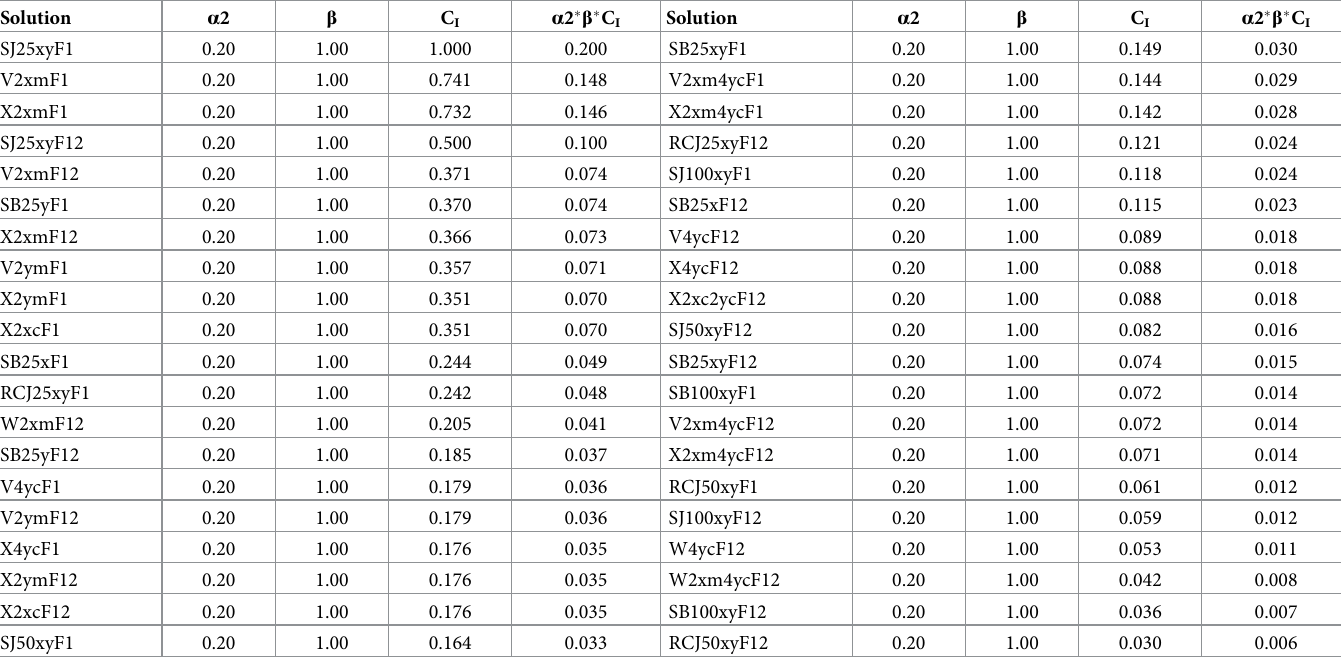
Table 3. The construction cost of each